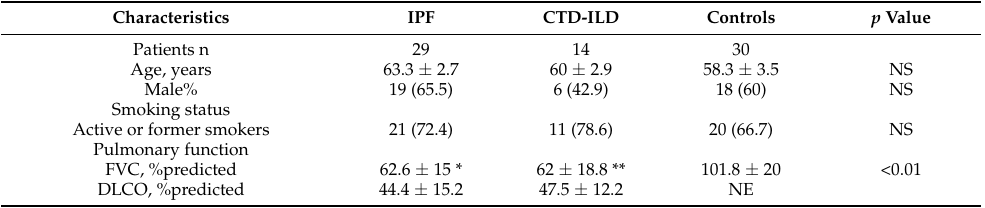
Table 1. Patient demographics and clinical characteristics. Continuous variables are expressed as the mean ( ± SD). Categorical data are expressed as n (%). IPF: Idiopathic pulmonary fibrosis. CTD-ILD: Connective tissue disease-associated interstitial lung disease. FVC: Forced vital capacity. DLCO: Diffusing capacity of the lung for carbon monoxide. NS: non-significant. NE: not evaluated. *: IPF versus healthy controls. **: CTD-ILD versus healthy